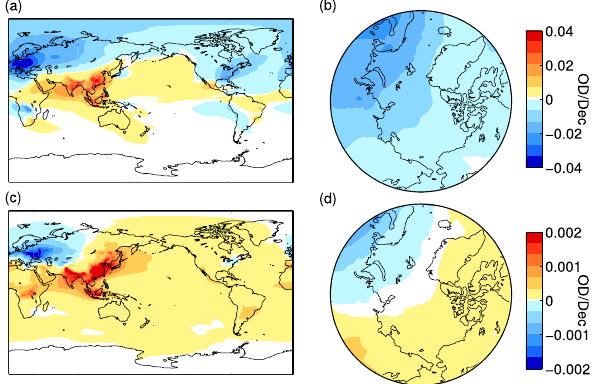
Figure 1 . Linear trends in optical depths per decade for sulfate (a, b) and black carbon (c, 426 Fig. 1. Linear trends in optical depths per decade for sulfate ( a, b ) and black carbon ( c, d ) for the period 1975–2005, both globally and d) for the period 1975-2005, both globally and for the Arctic. 427 for the